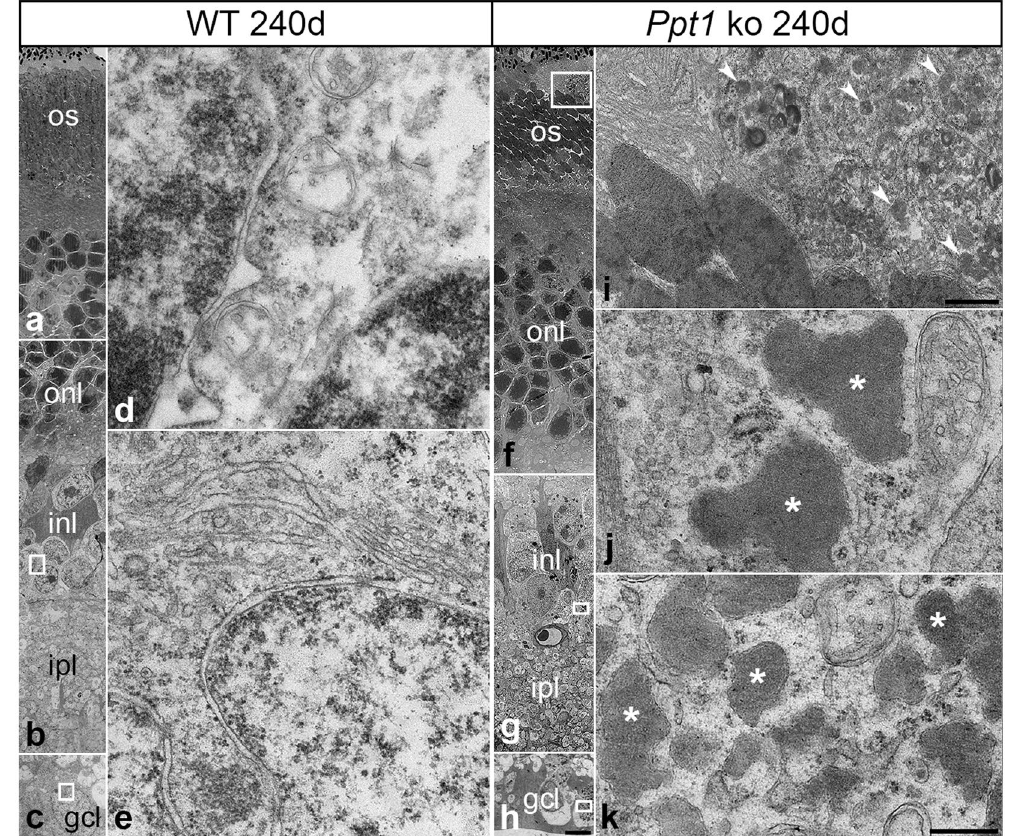
Figure 3. Ultrastructural analysis of storage material in the retina of Ppt1 ko mice. Low-power electron micrographs depict the different layers of a 240-day-old wild-type ( a–c ) and age-matched Ppt1 ko retina ( f–h ). Analyses of the boxed areas in ( f–h ) at higher magnification revealed the presence of granular osmiophilic deposits in subretinally located macrophages (arrowheads in i ), retinal interneurons (asterisks in j ) and retinal ganglion cells (asterisks in k ) respectively of Ppt1 ko retinas. Similar cytoplasmic inclusions were not detectable in retinas of age-matched control mice ( d,e ). gcl: ganglion cell layer; inl: inner nuclear layer; ipl: inner plexiform layer; onl: outer nuclear layer; os: outer segments. Scale bar in ( h ) (for a–c,f–h ): 5 μ m; in ( i ): 1 μ m; in ( k ) (for d,e,j,k ): 0.2 μ